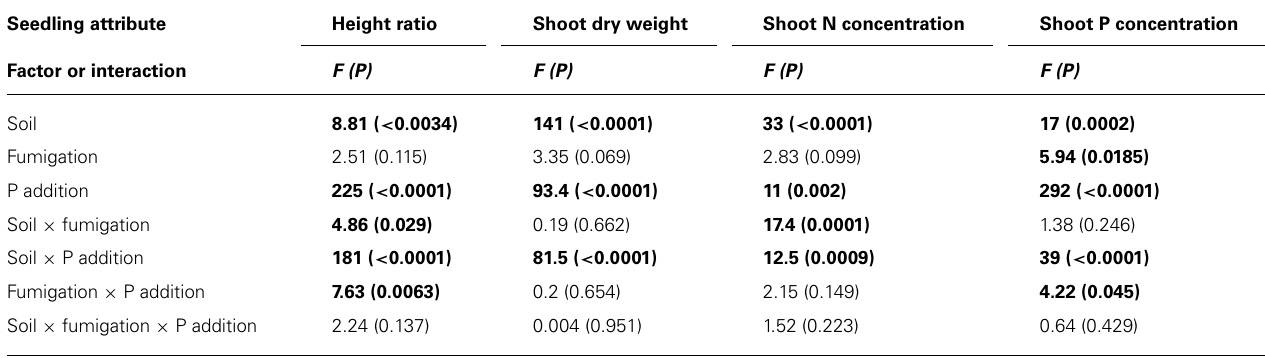
Table 2 |Three-way analysis of variance results for the effects of soil type, fumigation, and phosphorus addition on Eucalyptus grandis seedling attributes 146 days after transplant (DAT). Seedling